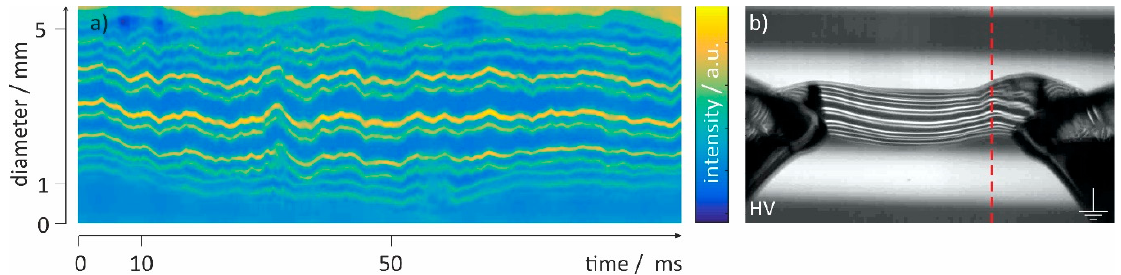
Figure 7. Time–space plot ( a ) from a water bridge ( b ) run at 19 kV and 1.0 mA, at the horizontal position indicated with a red, dashed line, bridge temperature ~50 °C.